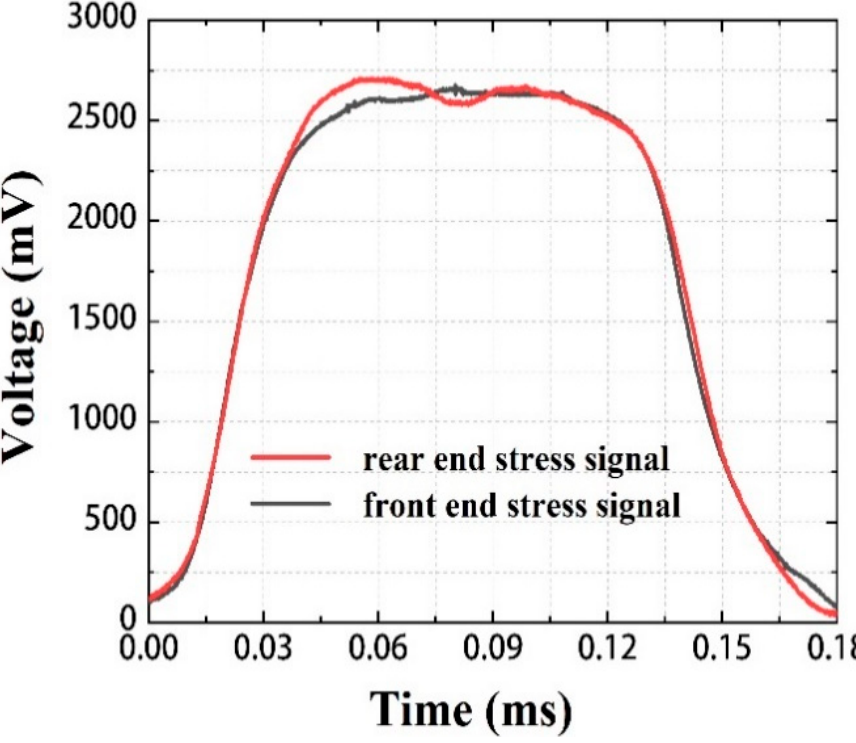
Figure 7. Front and rear stress signals of the specimen under dynamic compression.